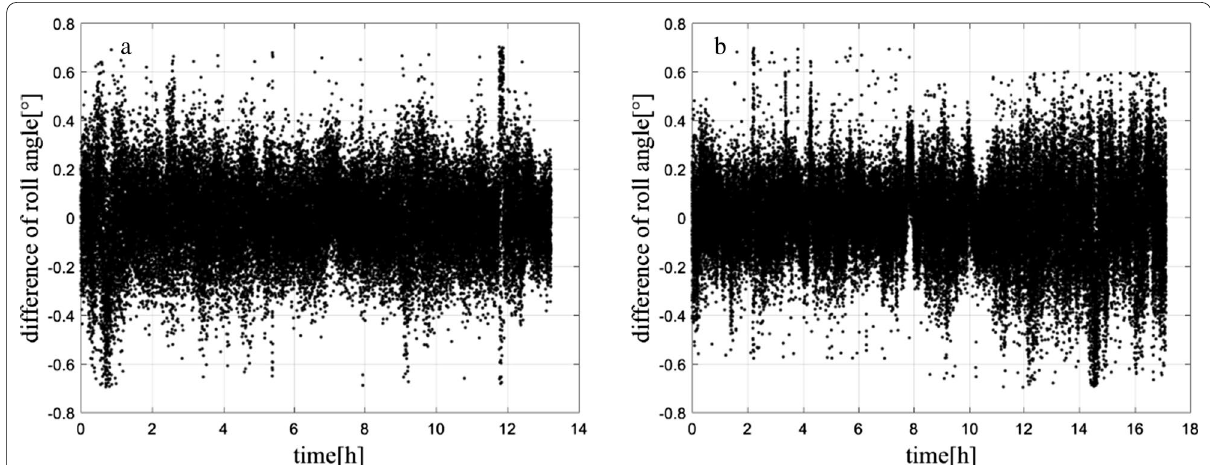
Fig. 10 The difference in the roll angle: a for H1-2 and b for X2-3